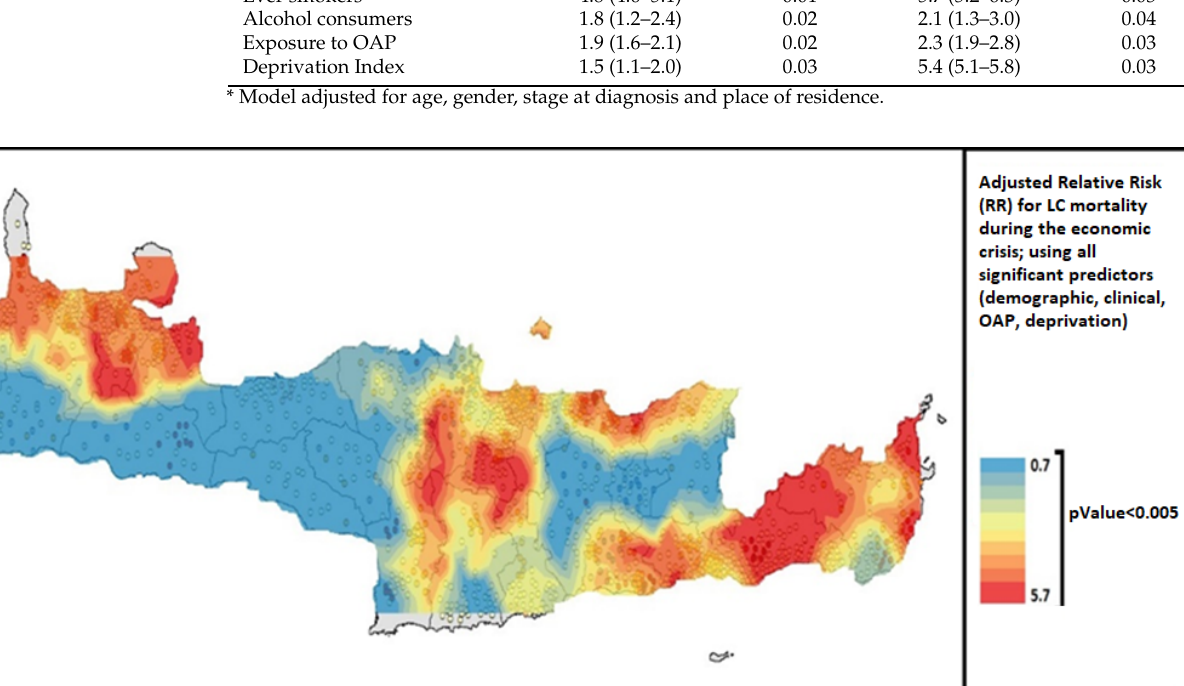
Table 2. Multiple predictors of LC mortality before and after the economic crisis, ( n = 3599). Covariates